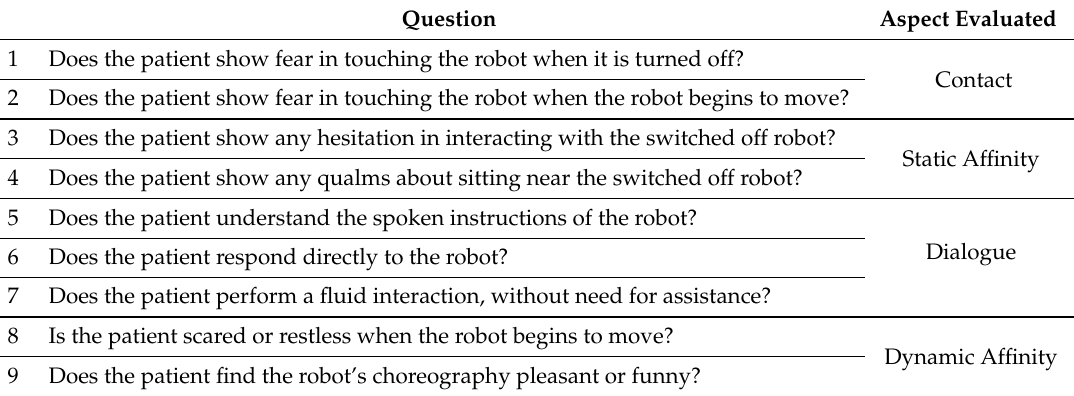
Table 2. Questions of the questionnaire and its relation with the evaluated aspects